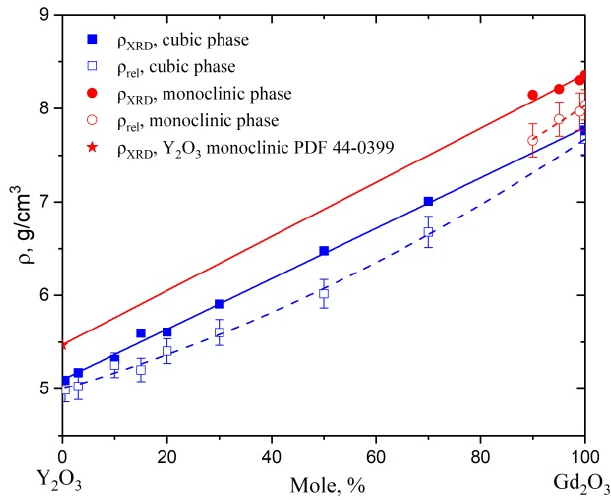
Figure 2. The experimental and theoretical XRD densities of solid solutions (Y 1 − x Gd x ) 2 O 3 .